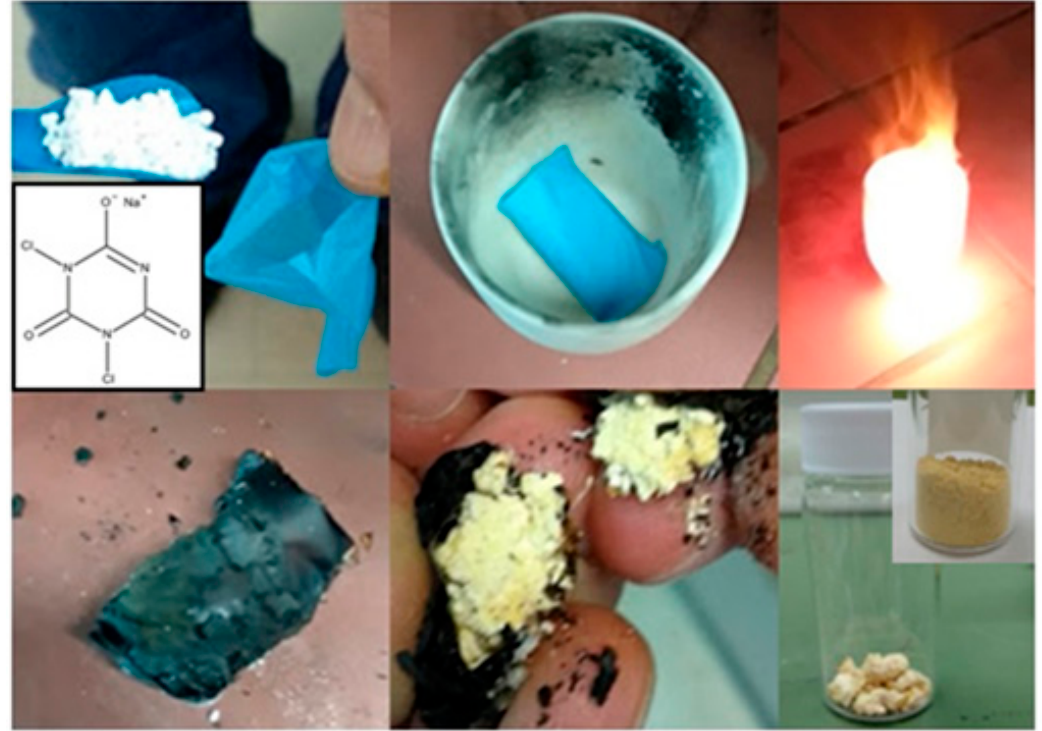
Figure 7. Top left to right bottom : the middle finger glove tip from a medium size nitrile glove was cut out and stuffed with granular dichloroisocyanuric acid, sodium salt hydrate (top inset structure). The stuffed tip was hermitically folded and placed at the bottom of an alumina crucible. After the quick addition of fuming nitric acid, the nitrile wrap was ignited, providing the necessary heat for the thermal transformation of the enclosed triazine derivative into graphitic carbon nitride. The inner product was mechanically separated from the outer carbon debris in the form of yellow chunks (glass vial at far-right bottom). Purification of the chunks afforded yellow graphitic carbon nitride powder (bottom inset).